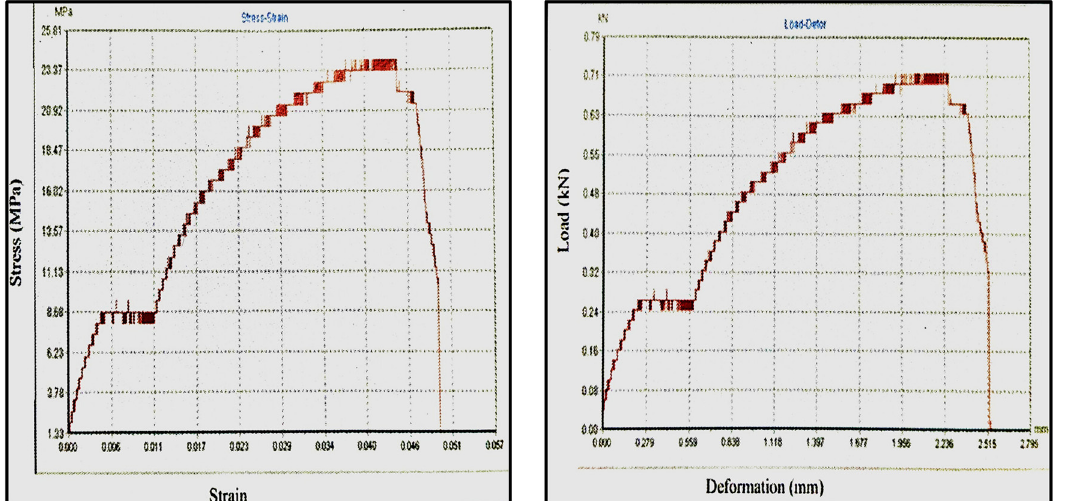
Figure 3: Stress – strain and load – deformation in the short